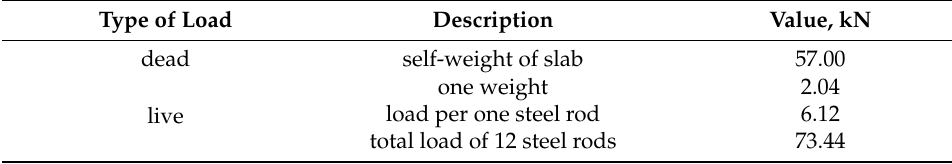
Table 1. Vertical loads of research models—details.